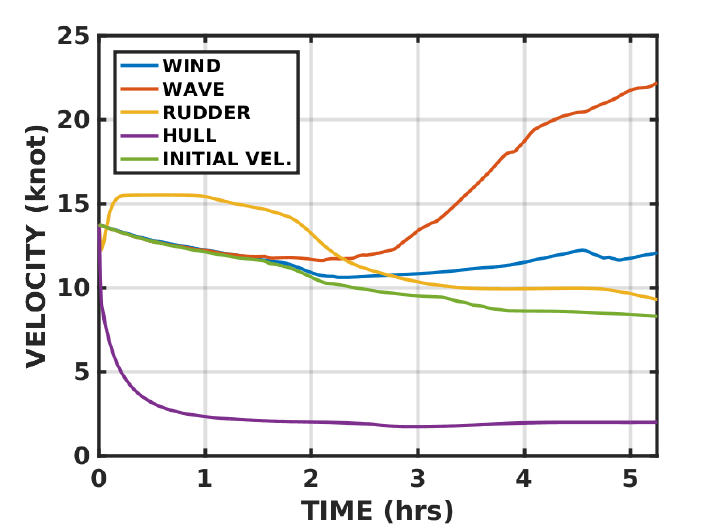
Figure 5. Timeline of ship’s